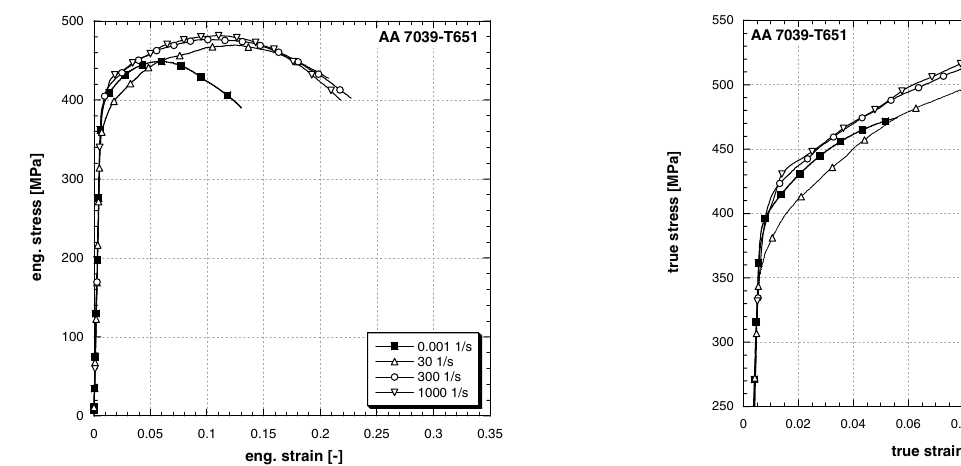
Fig. 7. Engineering stress versus strain at di ff erent strain-rates for AA 7039-T651.